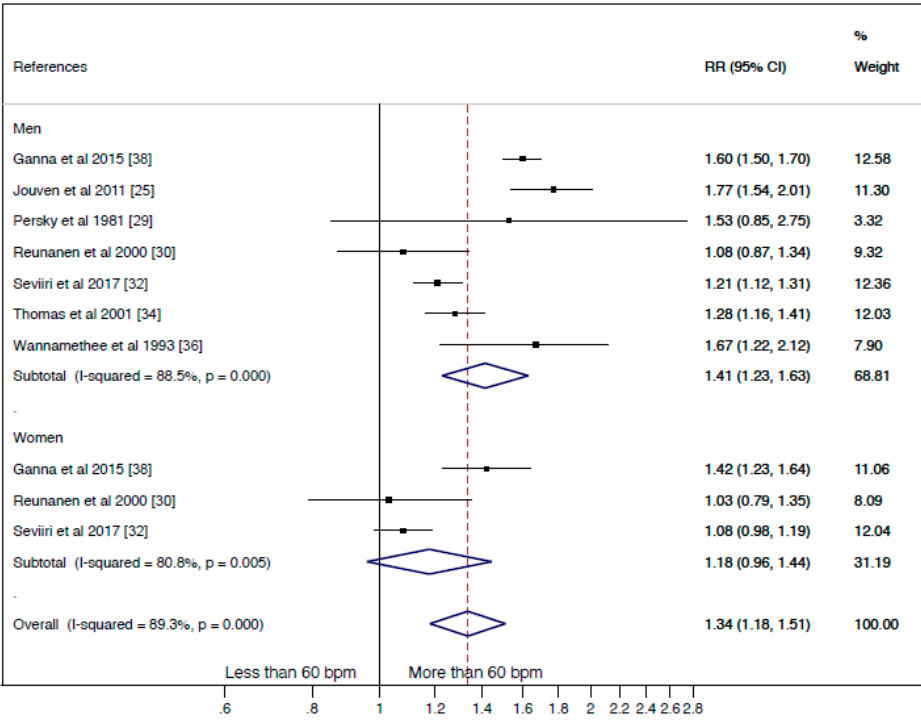
Figure 2. Forest plot of relative risk (RR) of cancer mortality for individuals with less than 60 beats per minute (bpm) of resting heart rate (RHR) category versus more than 60 bpm of RHR category, by gender and overall.